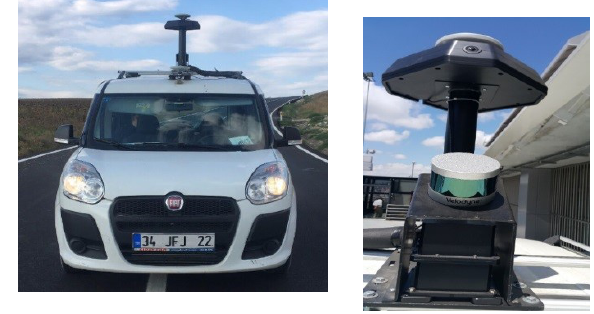
Figure 11: Mobile mapping